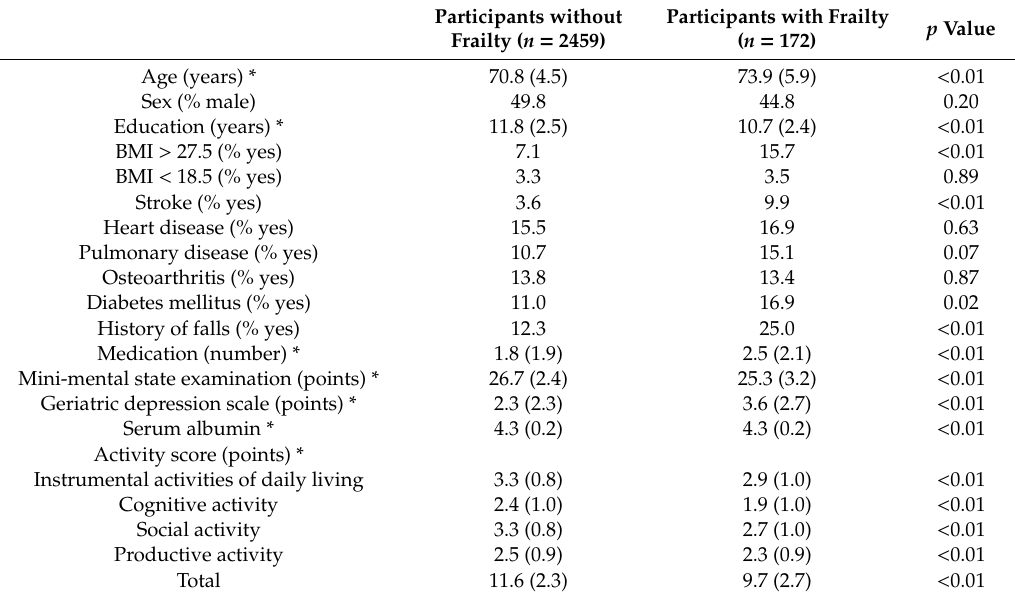
Table 2. Comparisons of baseline characteristics according to frailty